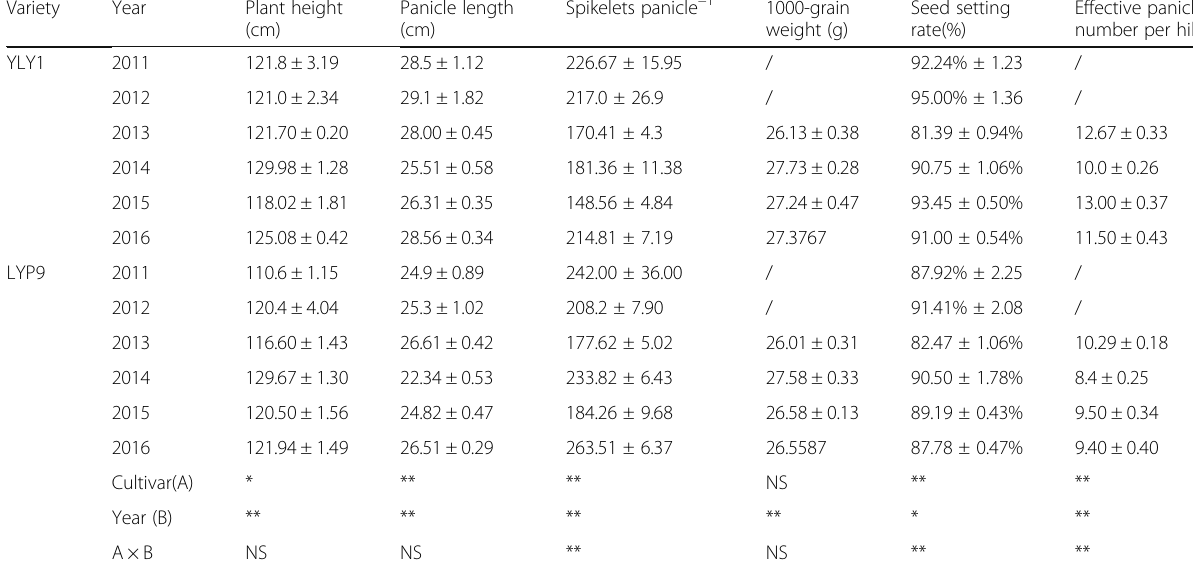
Table 6 Yield components, plant height and panicle length for YLY1 and LYP9 from 2011 to 2016. n = 10, “ *, ” “ ** ” represent significance levels of p = 0.05 and p = 0.01 levels